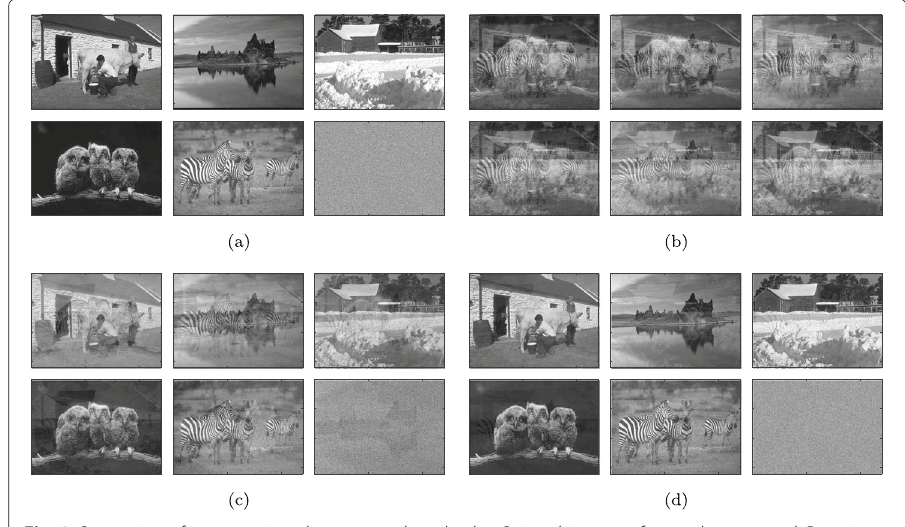
Fig. 3 Separation of images using the proposed method. a Original images of natural scenes and Gaussian noise. b Linearly mixed images. c Separated images after 2 sweeps. d Separated images after 10